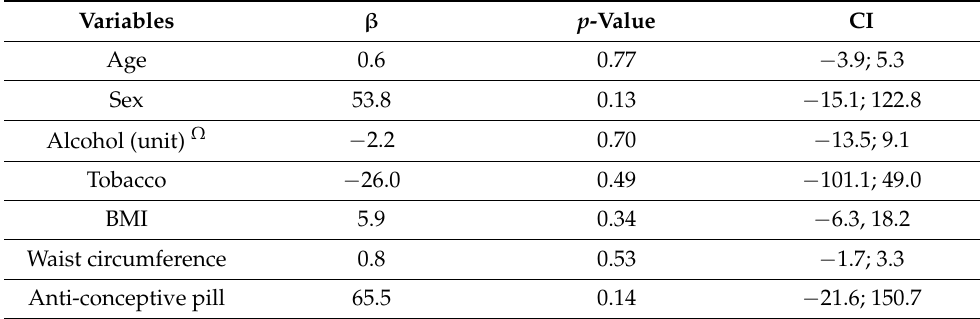
Table 2. Generalised Linear Models between the among of extracted earwax using the self-sampling external ear device and some biological